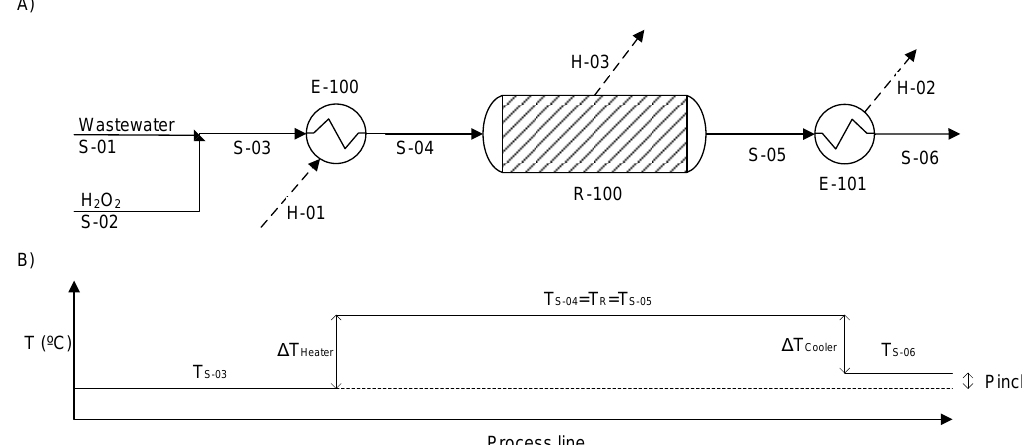
Figure 1. Flowsheet of the Catalytic Wet Peroxide Oxidation (CWPO) process implemented in the ASPEN Plus ® v11 simulator ( A ) and the temperature line diagram of the process ( B ).